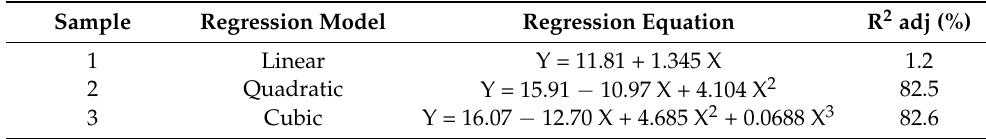
Table 3. The orthogonal polynomial regression model for the compressive strength of the mortar with OPS-activated charcoal.